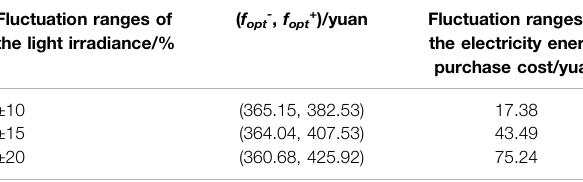
TABLE 5 | Electricity energy purchase costs under different light irradiance fl uctuation